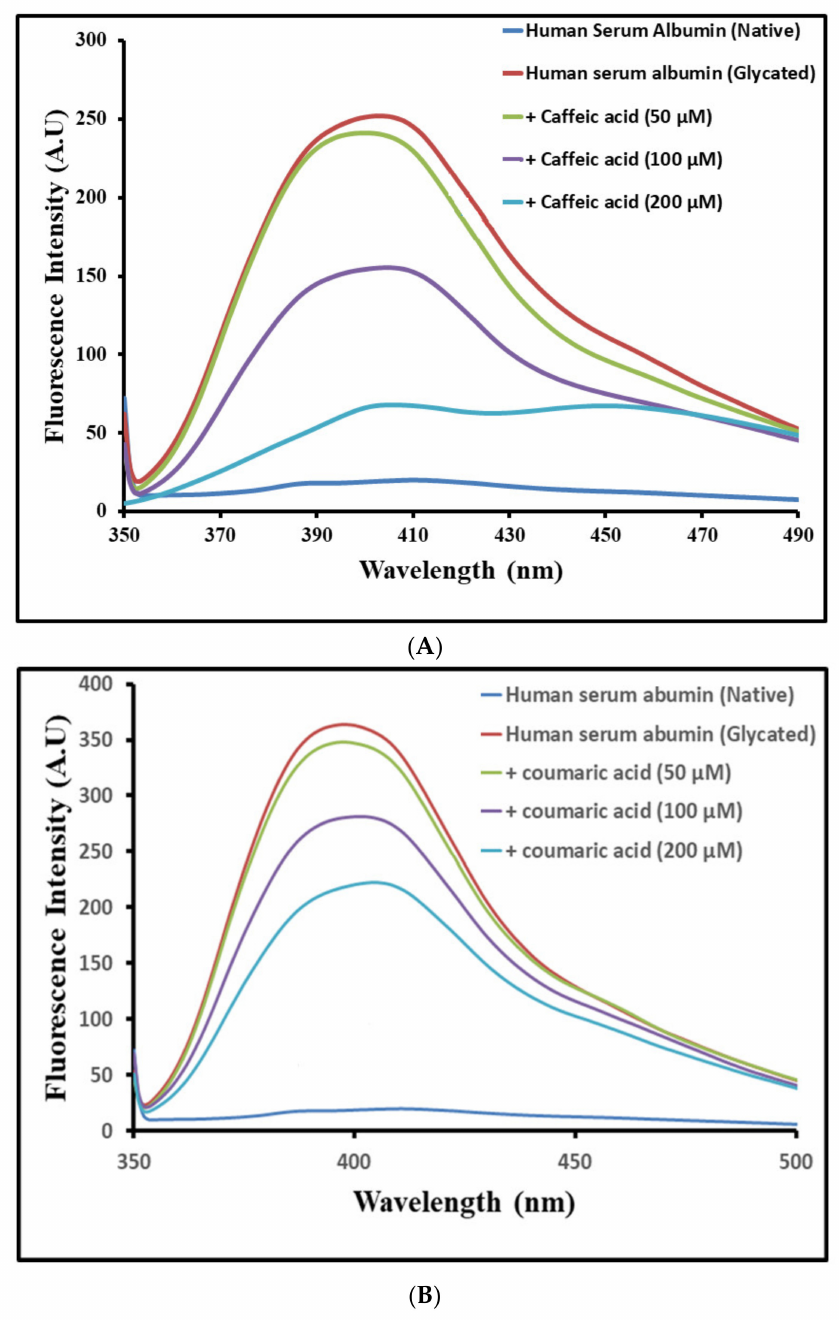
Figure 4. Inhibition of fluorescent advance glycation product (AGEs) by ( A ) caffeic acid and ( B ) p-coumaric